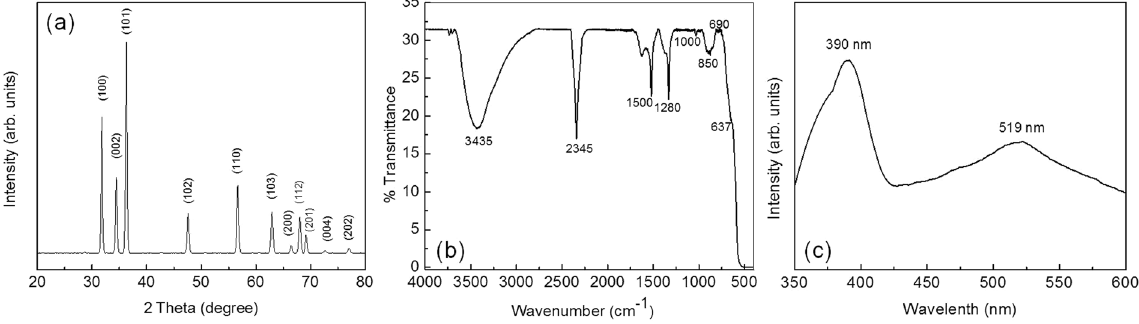
Figure 1. ( a ) XRD pattern, ( b ) FTIR spectrum, and ( c ) photoluminescence spectrum of Fe/ZnO